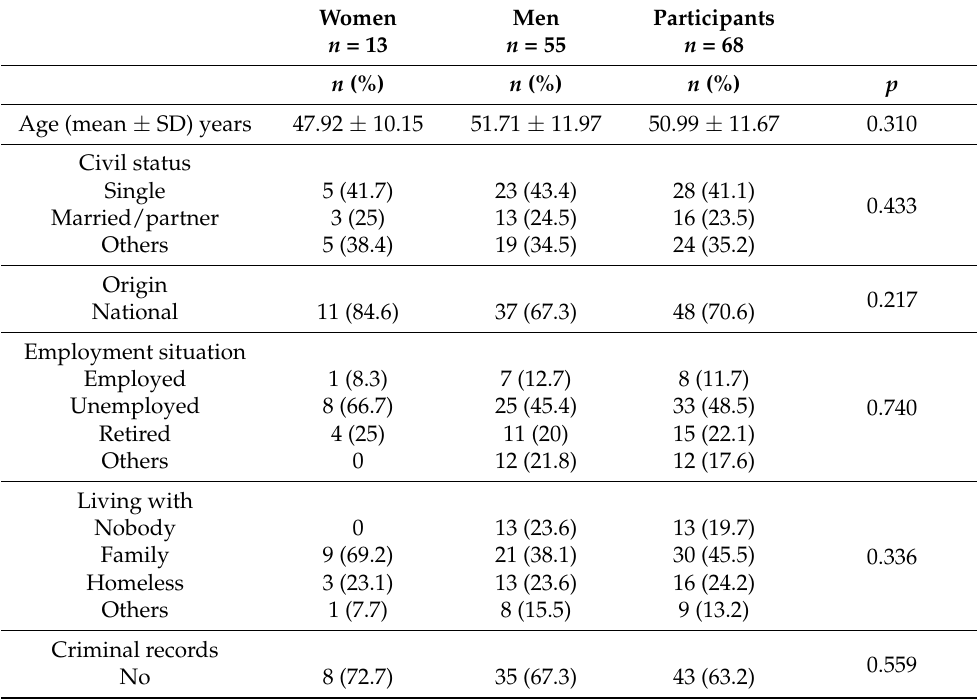
Figure 1. Flowchart for study enrolment. Table 1. Demographic characteristics of the sample stratified by